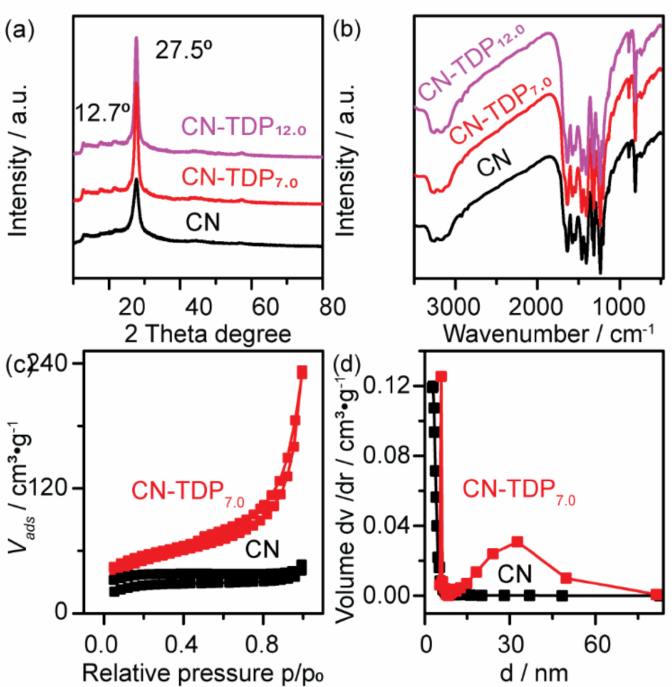
Figure 1. ( a ) PXRD ( b ) FT-IR, ( c ) Nitrogen adsorption-desorption, ( d ) corresponding pore size distribution for CN and modified CN-TDP 7.0